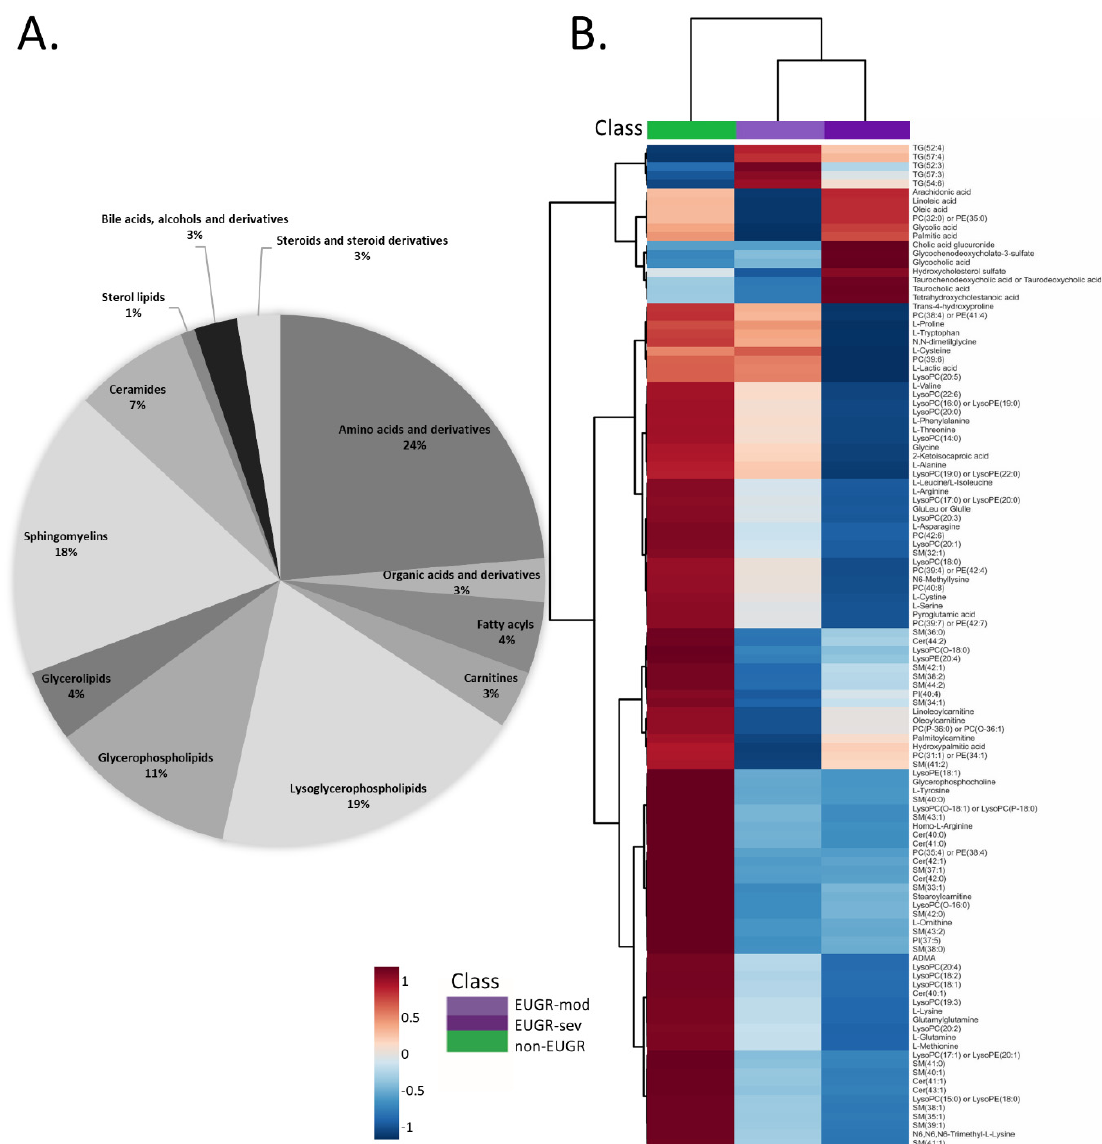
Figure 2. ( A ) Panel A. Pie chart representing the distribution of metabolites identified from multiplatform metabolomic analysis that were significantly di ff erent between EUGR and non EUGR individuals. ( B ) Panel B. A hierarchical clustering with heatmap using Euclidean distance measure and Ward clustering algorithm has been applied for statistically significant metabolites, illustrating the di ff erences in the metabolite abundance between non-EUGR, EUGR-mod and EUGR-sev cases. Each colored cell corresponds to an abundance value, where blue indicates the lowest and red the highest value.